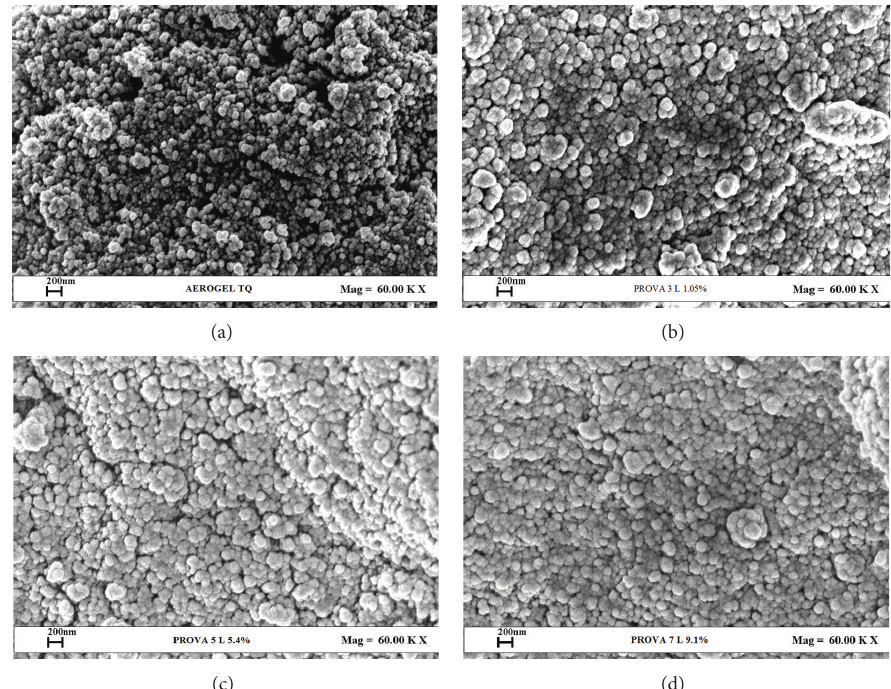
Figure 4: FE-SEM photographs of (a) not treated SA and SA samples loaded with different amount of nimesulide: (b) 1.0wt%, (c) 5.4wt%, (d)